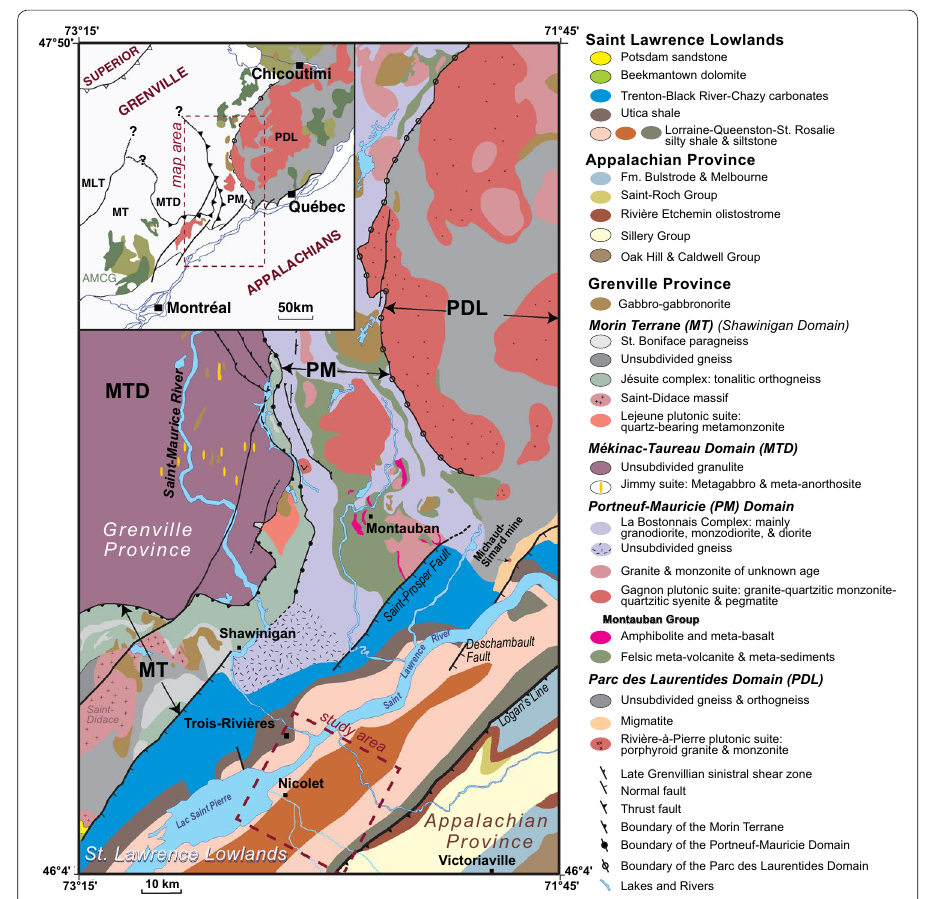
Fig. 4 Simplified regional geology. Geology of the Grenville Province is taken from Nadeau and Brouillette (1994, 1995); St. Lawrence Lowlands and Appalachian Province geology is from SIGÉOM (2018). Dashed maroon square indicates the study area. Inset map is modified after (Charlier et al. 2010)